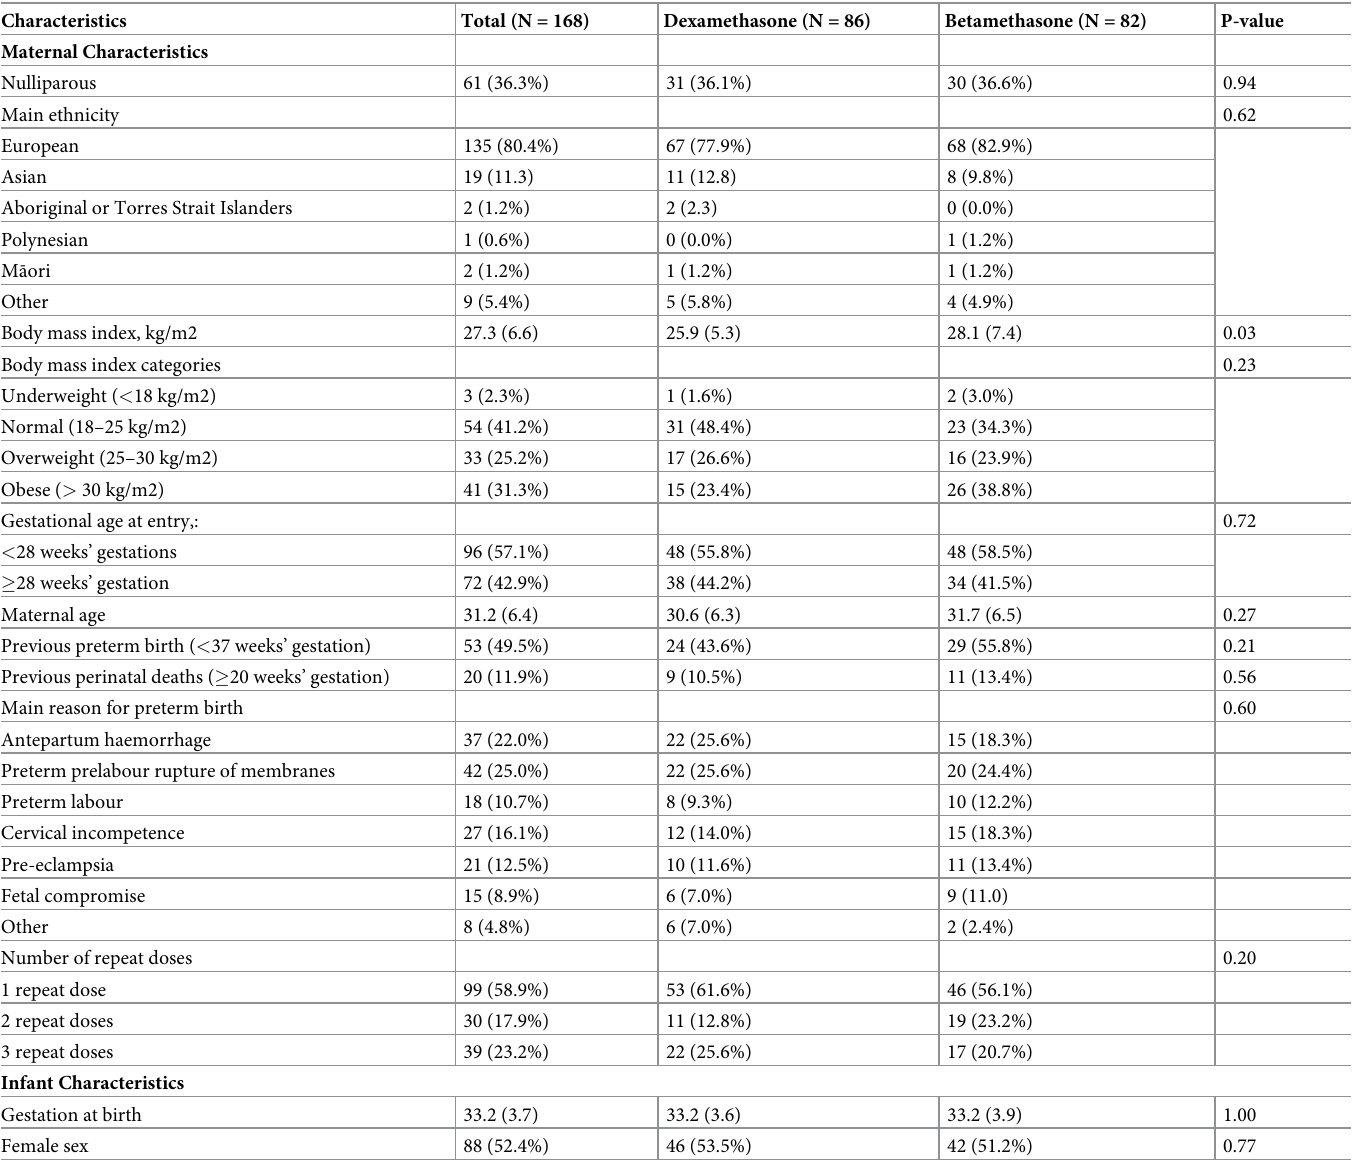
Table 1. Maternal, infant and childhood characteristics of the